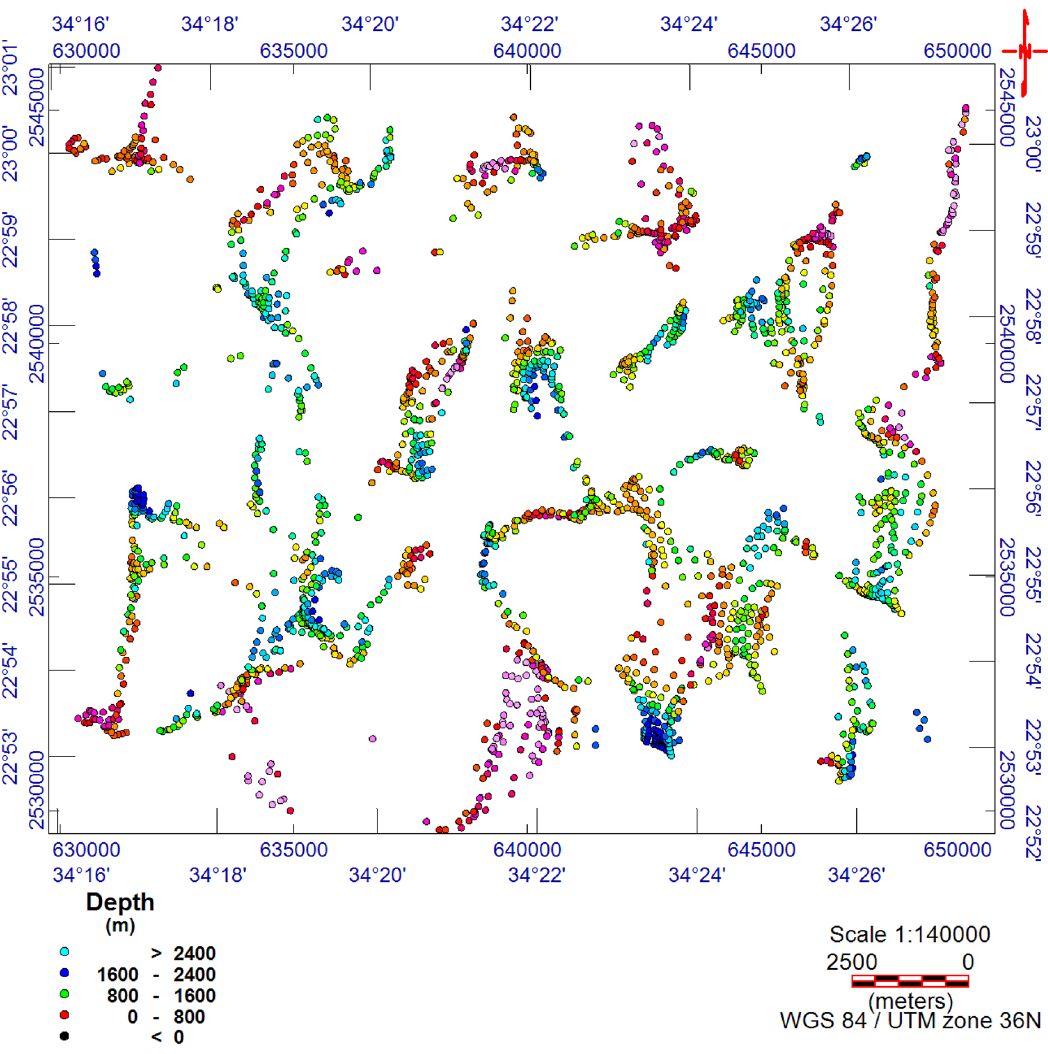
Figure 6. The EUD map of Akab El-Negum